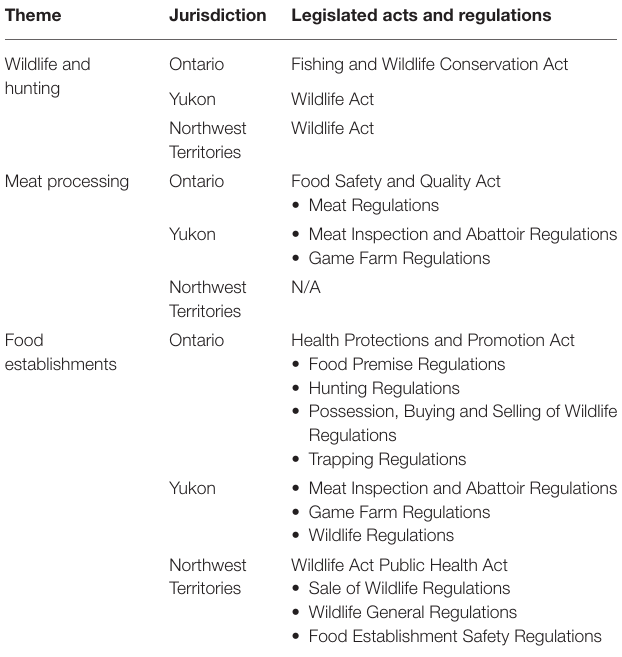
TABLE 2 | Identified policies organized by